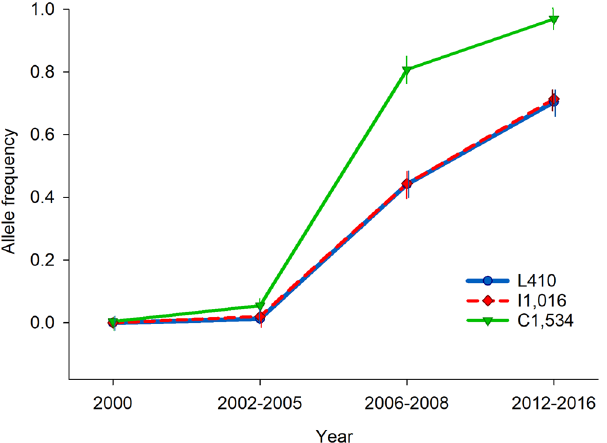
Figure 2. L410, I1,016 and C1,534 allele frequencies in 25 Ae. aegypti collections from Southern Mexico. Allele frequencies are plotted in four periods of time: 2000 (n = 233), 2002–2005 (n = 346), 2006–2008 (n = 223)